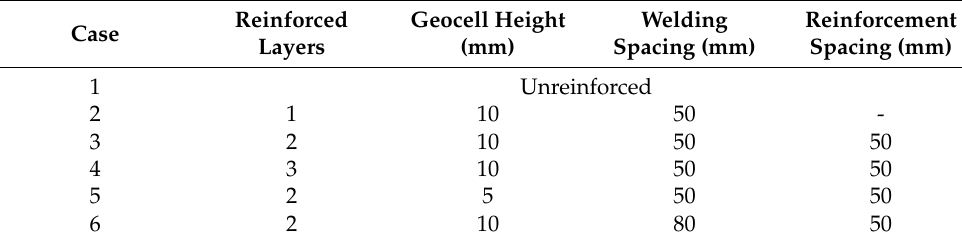
Figure 4. Equipment and specimen. Table 3. Reinforcement test